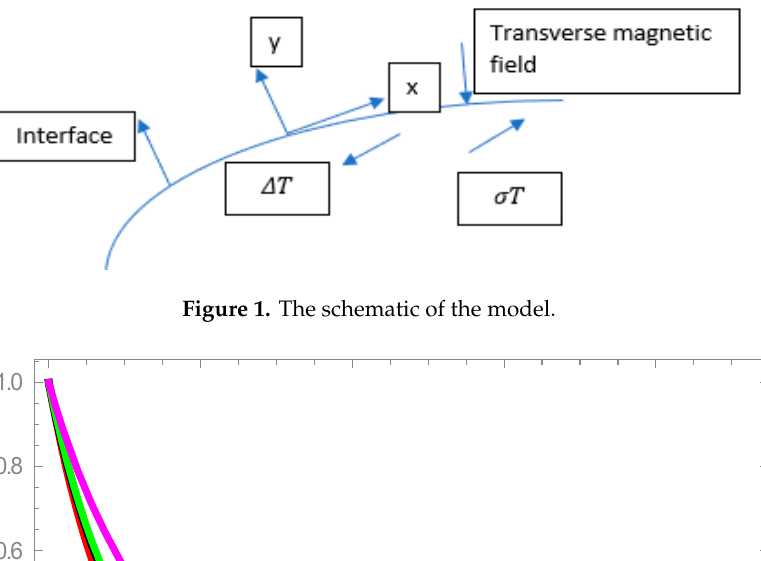
Sphere Red Platelet Black Column Green